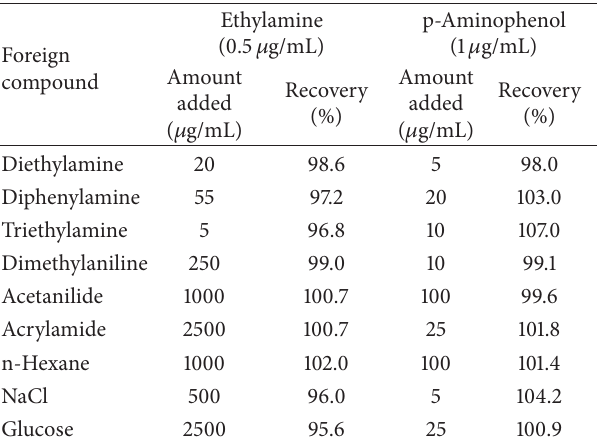
Table6:Effectofforeigncompoundontherecoveriesofethylamine and